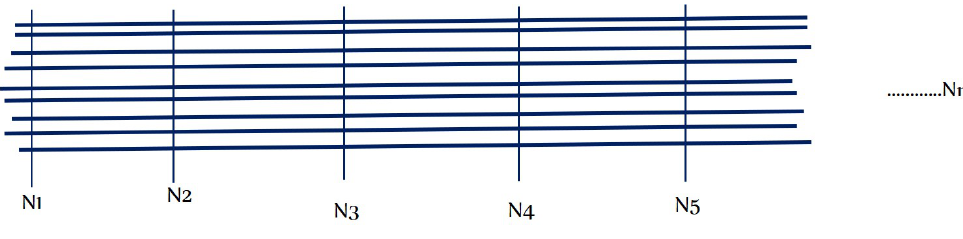
Figure 7. Distribution of filaments.